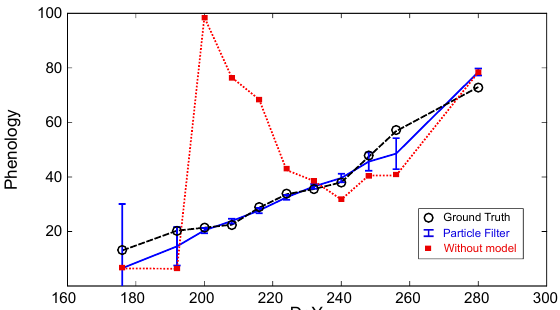
Figure 6. Comparison for one parcel during one year campaign of phenological state estimates provided by the full particle filter approach (solid blue line) with estimates obtained without taking into account the prediction model (red squares). Ground truth data are represented with black